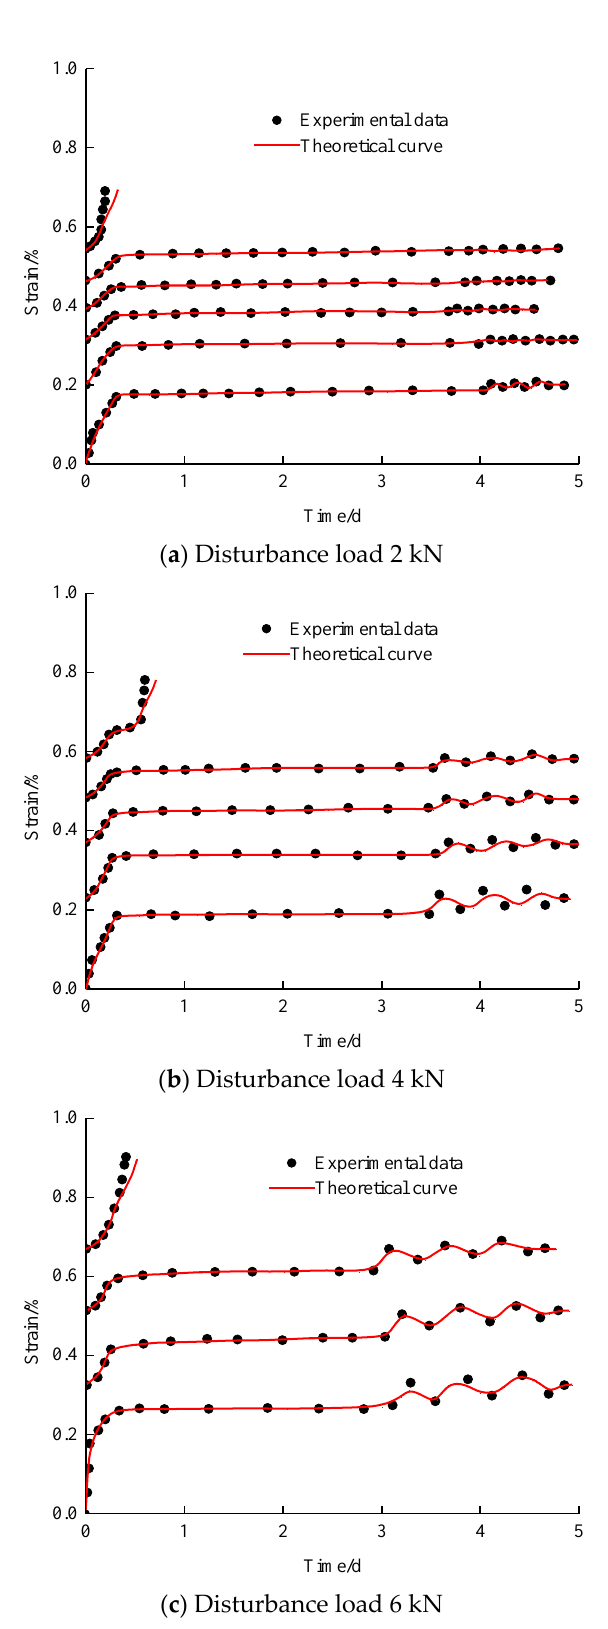
Figure 11. Theoretical axial creep curves of rock under different disturbance loads.